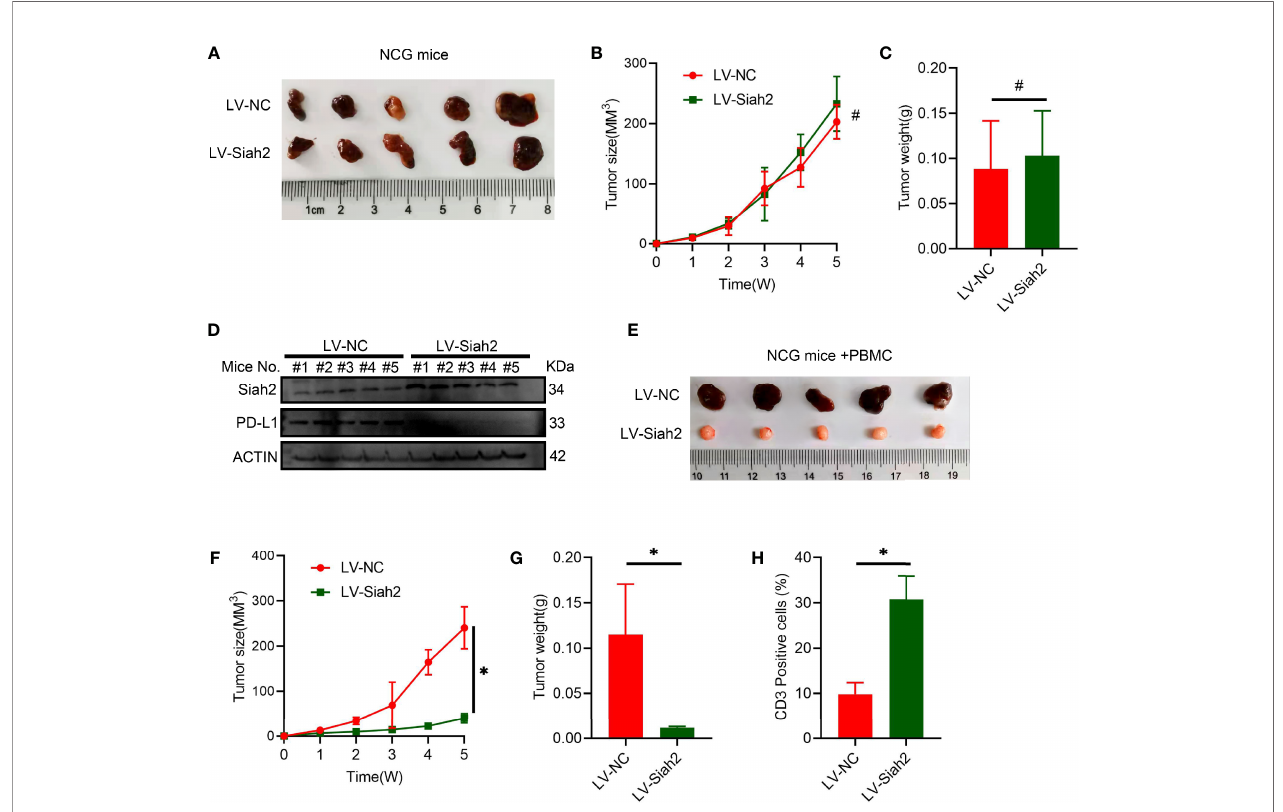
FIGURE 6 | Siah2 enhanced in vivo antitumor T-cell activity. (A – C) , CCA cells with LV-NC/LV-Siah2 were injected subcutaneously into the right fl ank of NCG mice to obtain tumor xenografts. Tumor volume (B) and tumor weight (C) were then measured. n = 5. ns, non-signi fi cant. Unpaired t test. (D) , Western blot analysis detected PD-L1 level in the subcutaneous xenografts described in (A – C) . (E – H) , CCA cells with LV-NC/LV-Siah2 were injected subcutaneously into the right fl ank of NCG mice, which were adoptively transferred with activated HPBMC. (E – G) , Images of subcutaneous xenografts (E) , tumor volume (F) , and tumor weight (G) are shown. N = 5. (H) , FCM detected the percentage of human CD3 + T cells in HPBMC of NCG mice. n = 5. Mean±SEM of three independent experiments. *P<0.05; # P >